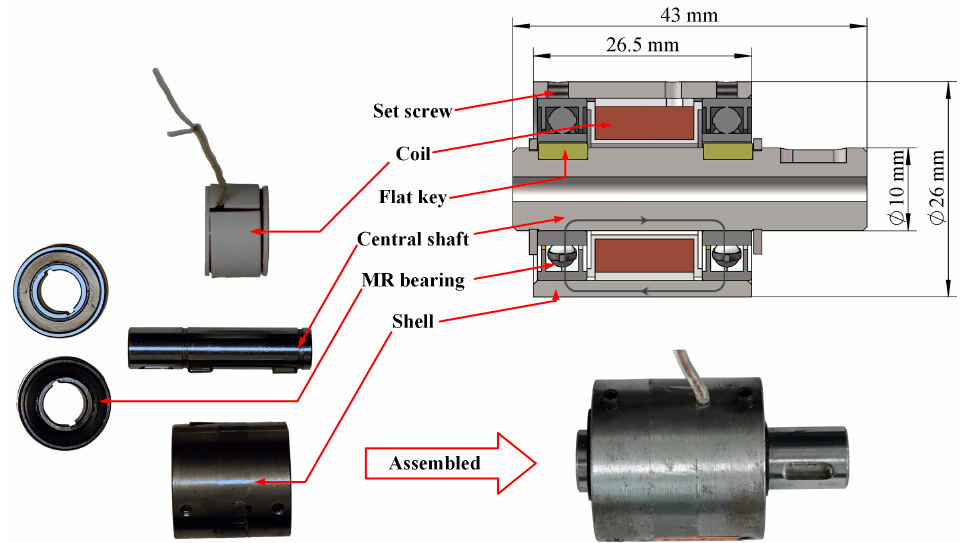
Figure 1. Structural design and prototype of the designed damper. The sectional view of the 3D model is on the top right. The flux direction is marked with a gray line. The structural components of the MR damper are on the left. The MR damper prototype, which is assembled from the components, is on the bottom right.